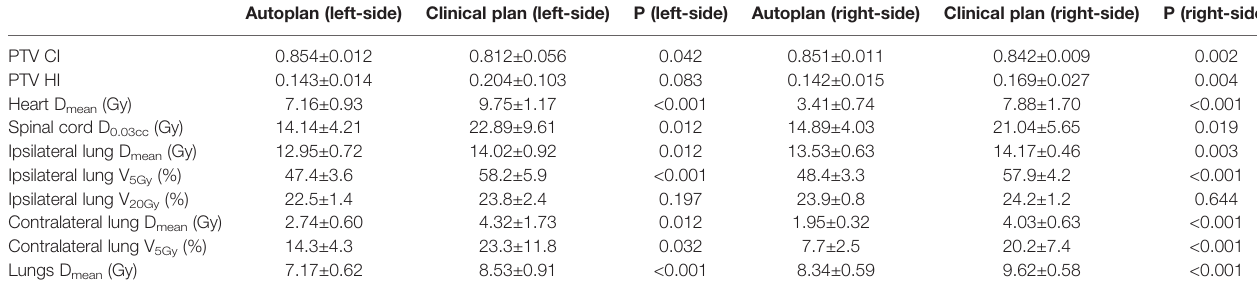
TABLE 11 | Dosimetric results (mean ± standard deviation) of postmastectomy VMAT autoplans and clinical plans. Autoplan (left-side) Clinical plan (left-side) P (left-side) Autoplan (right-side) Clinical plan (right-side) P (right-side)